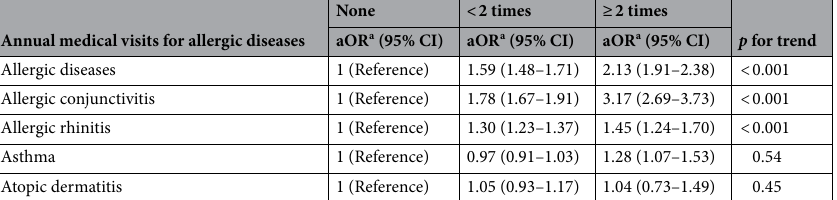
Table 4. Association between AMD and annual medical visits for allergic diseases. AMD age-related macular degeneration, aOR adjusted odds ratio, CI confidence interval. a Model was adjusted for sex, age, urbanization level, occupation category, monthly income, and comorbidities of hypertension, diabetes, hyperlipidemia, and obesity.